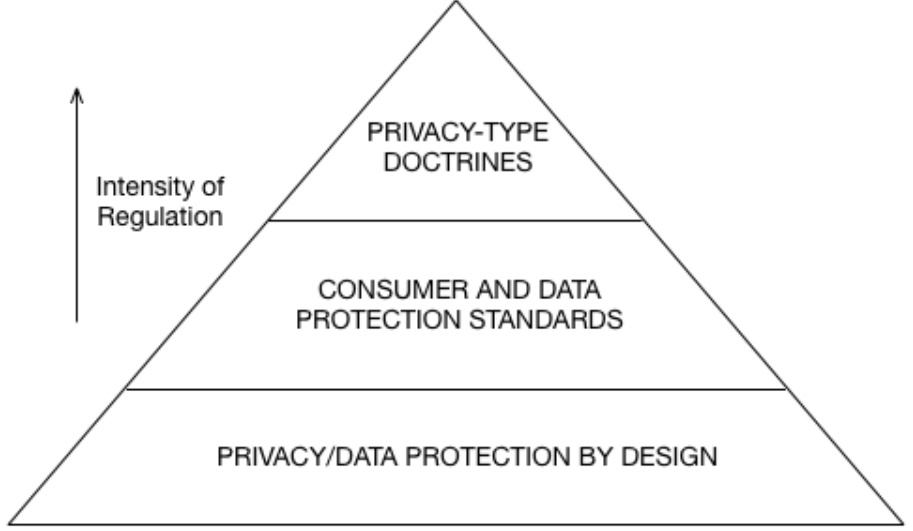
Figure 1: Responsive regulation pyramid for the